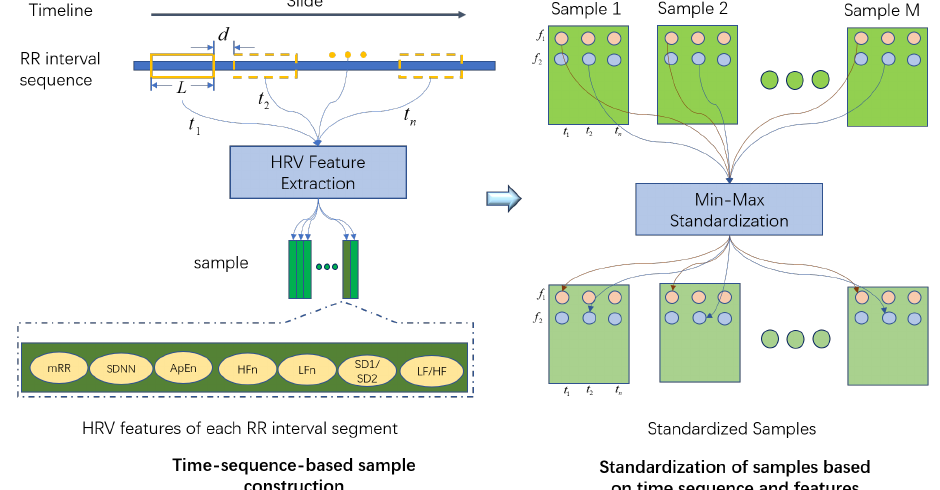
Figure 6. Sample construction and